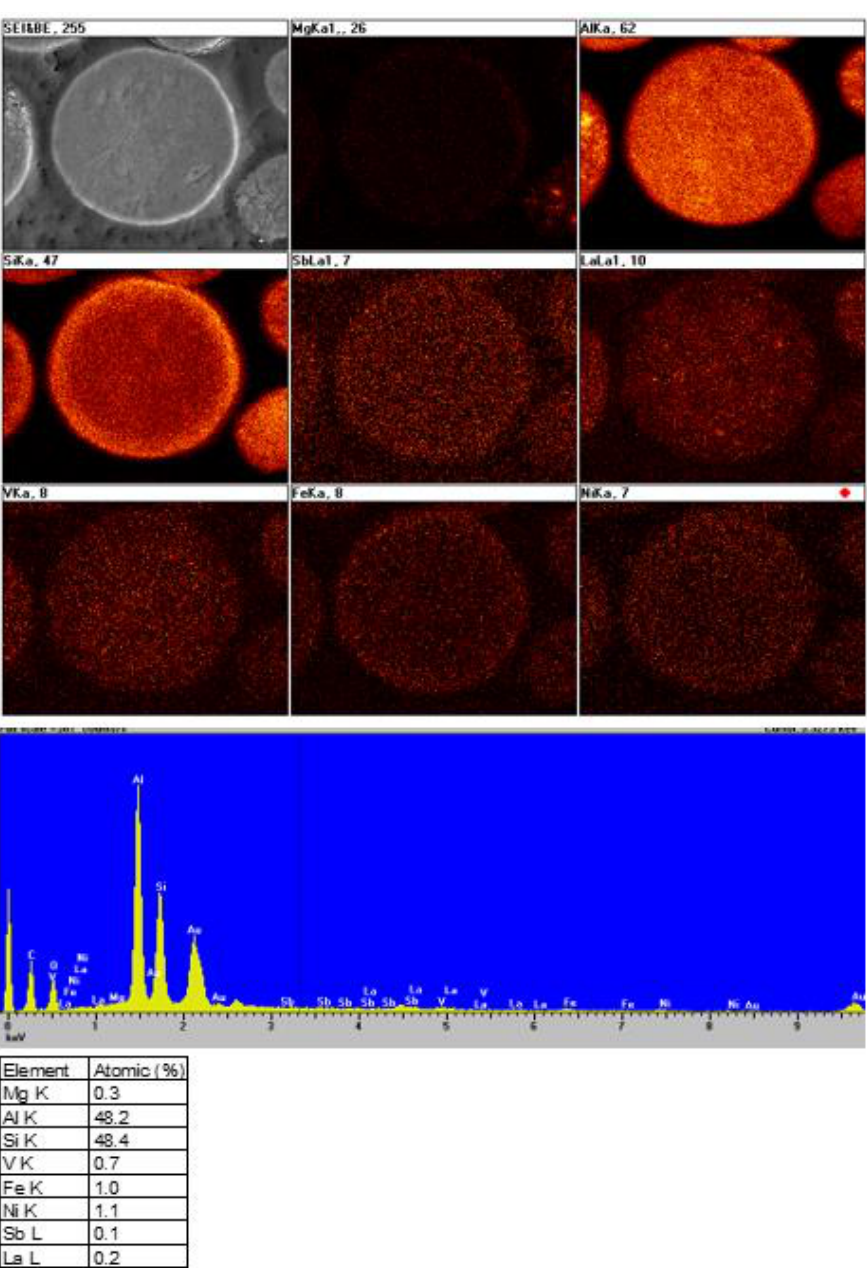
Figure 19. SEM image and EDS elemental mapping of equilibrium FCC catalyst: B-CAT-5M (5141 ppm Ni).